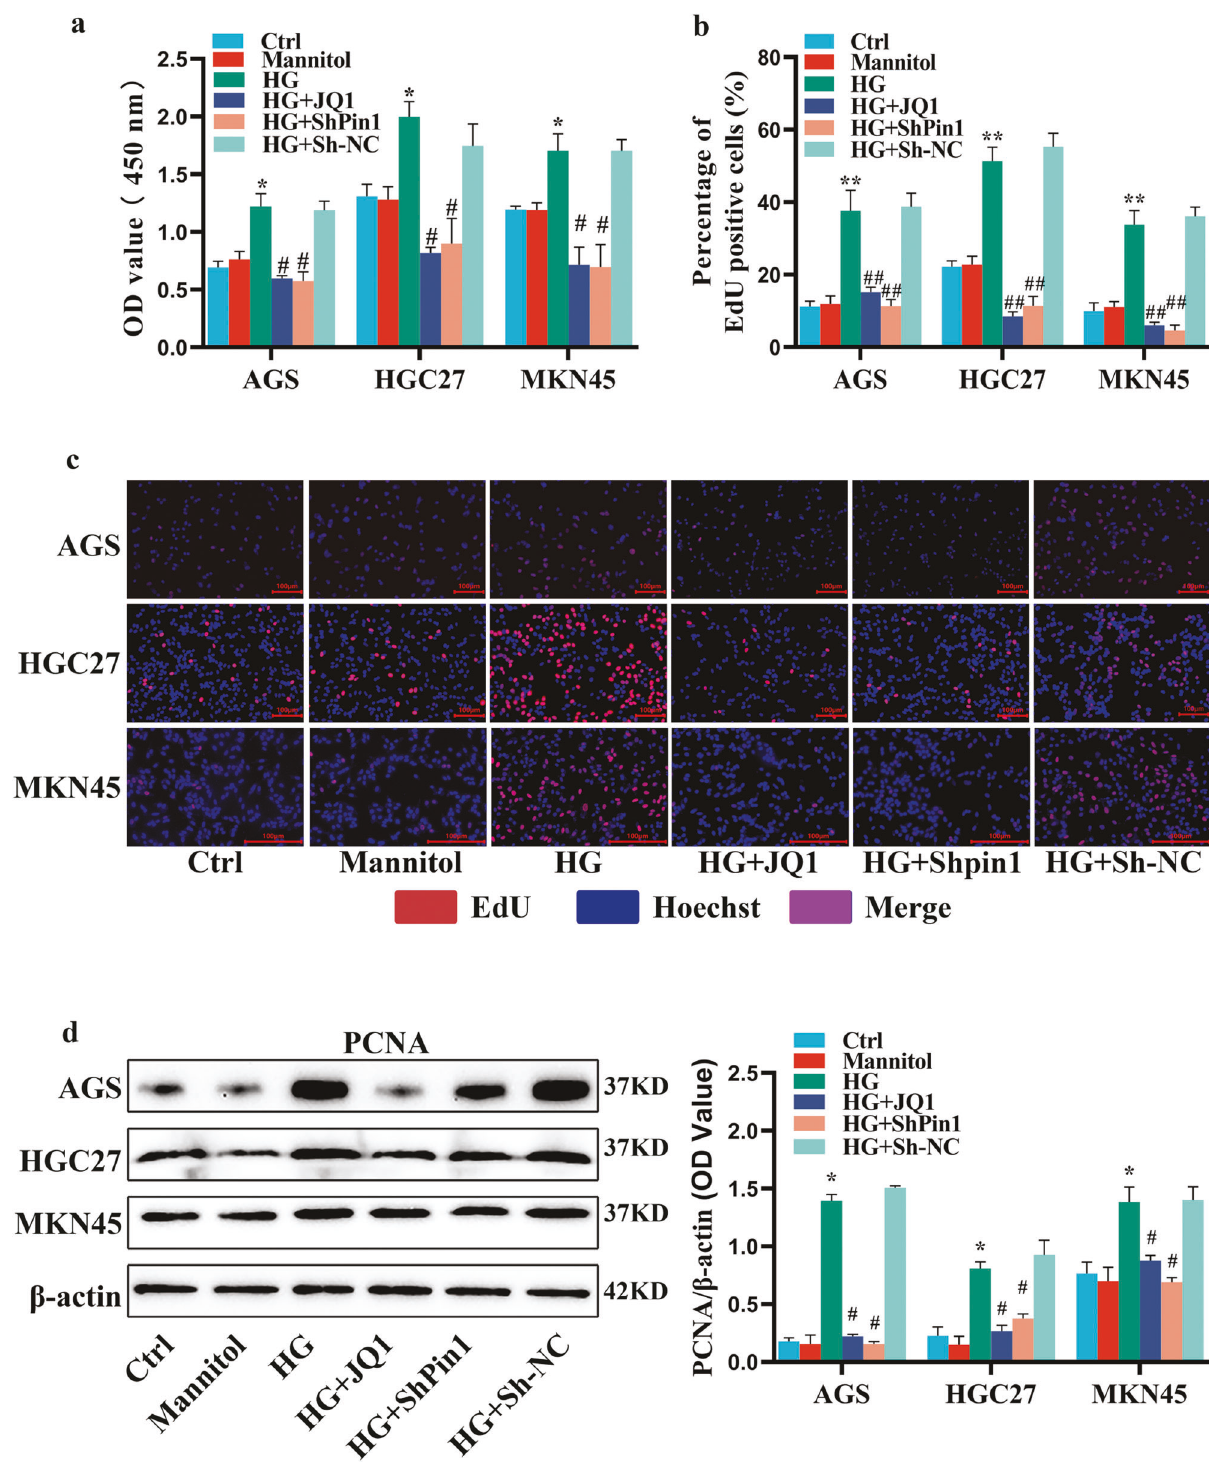
Fig. 1 Effect of silencing Pin1 or BRD4 on proliferation of GC cells induced by HG. a CCK-8 assay was used to measure proliferation of GC cells. Cells were infected with lentivirus vector of ShPin1 or Sh-NC or were pretreated with JQ1 (10 − 6 M) for 1 h and incubated with HG for 72 h. b , c GC cell proliferation was measured using EdU assays. EdU (red) and nuclei (blue, Hoechst) indicate proliferation. Scale bars, 100 μ m. d PCNA proteins were extracted for WB. β -actin represents loading control. Values are mean ± SEM. * P < 0.05 vs. Ctrl; ** P < 0.01 vs. Ctrl; # P < 0.05 vs. HG; ## P < 0.01 vs. HG. All the experiments were performed 3 times.